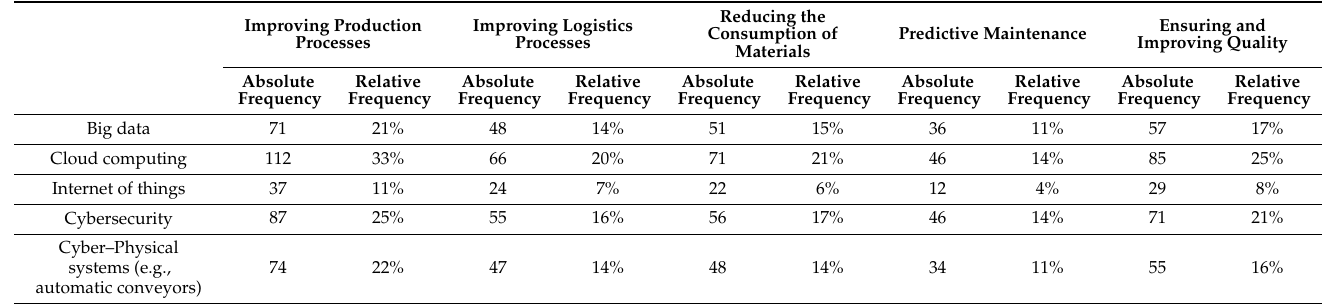
Table 7. Impact of collected data from selected Industry 4.0 attributes on processes.